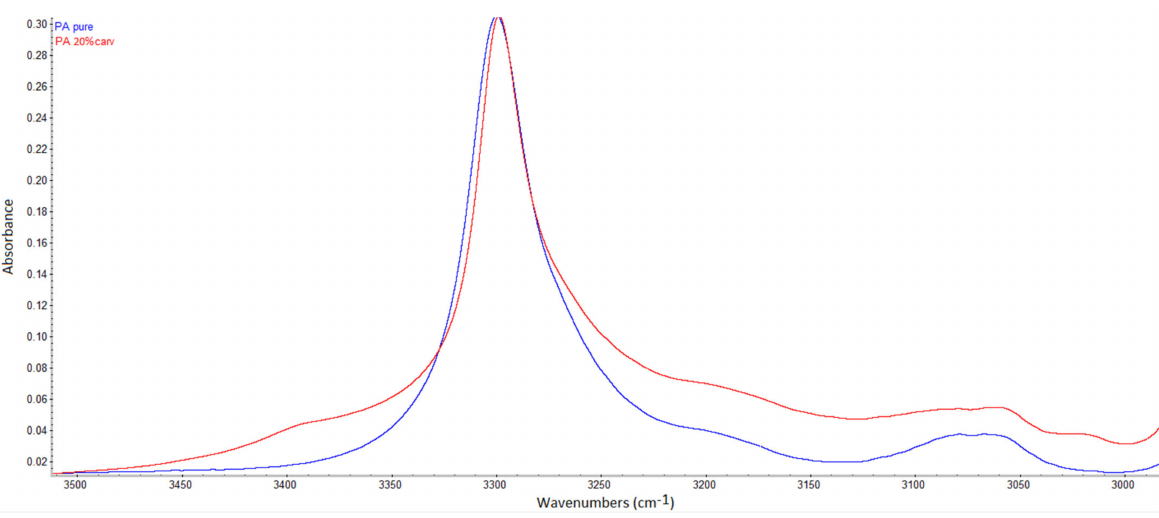
Figure 7. N–H stretching vibration bands in polyamide (peaks 3299 and 3076 cm − 1 ) and carvacrol-impregnated polyamide (3298 and 3065 cm − 1